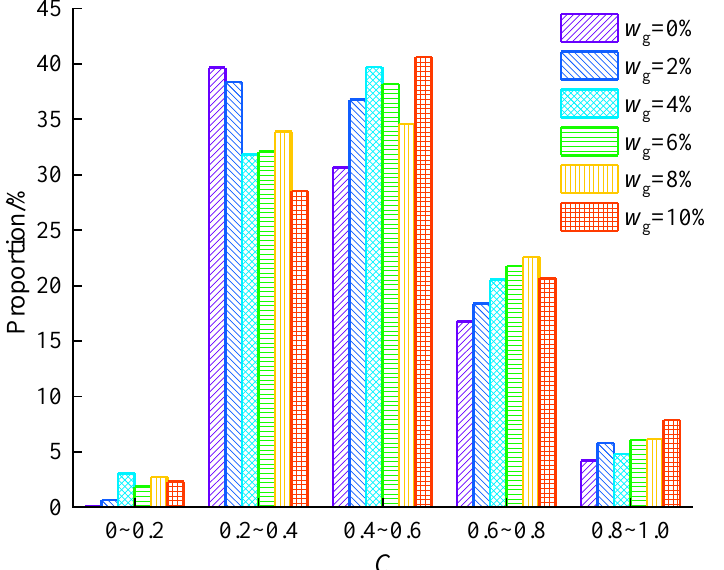
Figure 17. Histogram of the micro-particle abundance of solidified waste silt.